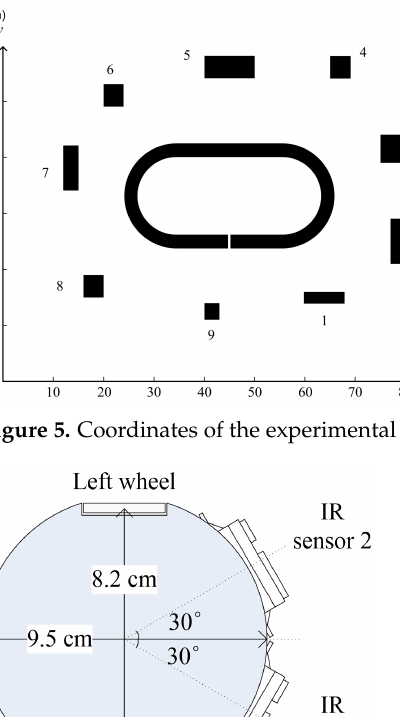
Figure 4. Experimental map.